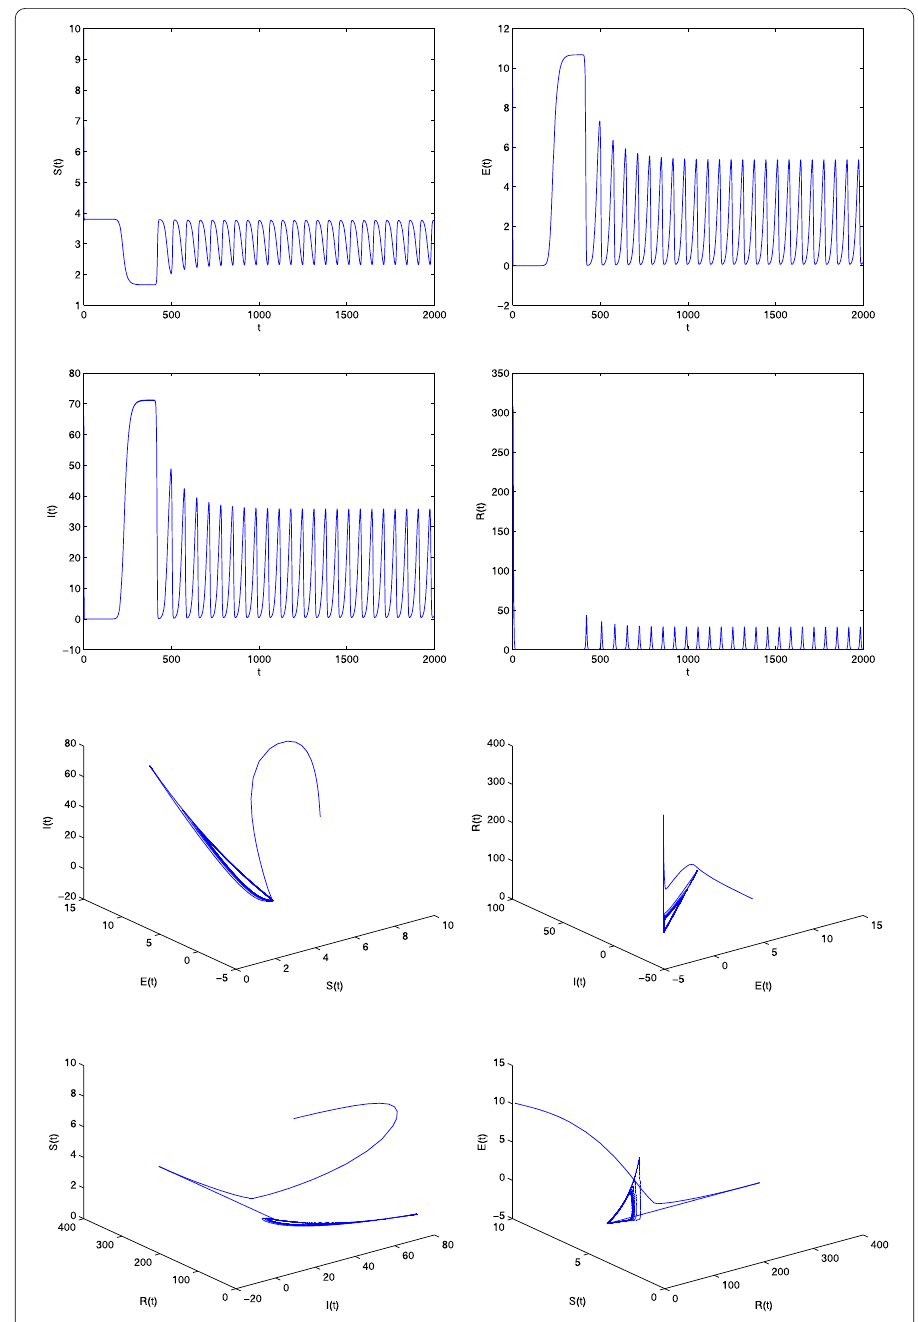
Figure 2 The phase diagrams of the system (2) undergoes Hopf bifurcation when τ = 2